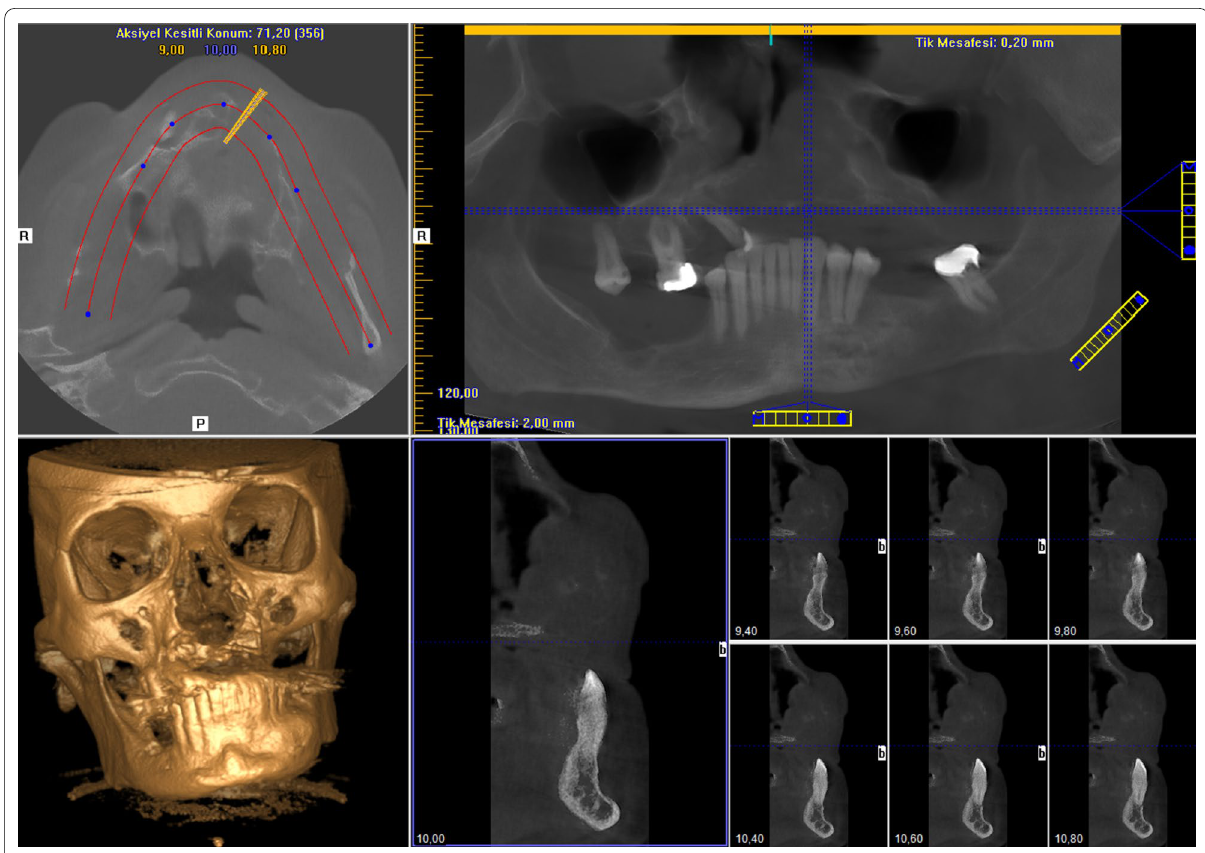
Fig. 4 CBCT view from the area where the lesion is highest; blue arrows